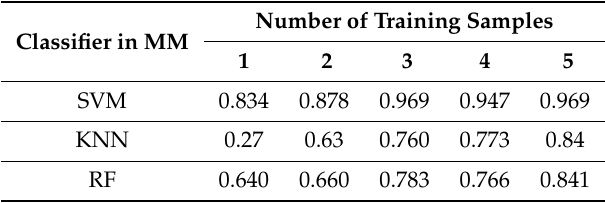
Table 3. Verification accuracy obtained using different classifiers on the IITD touchless